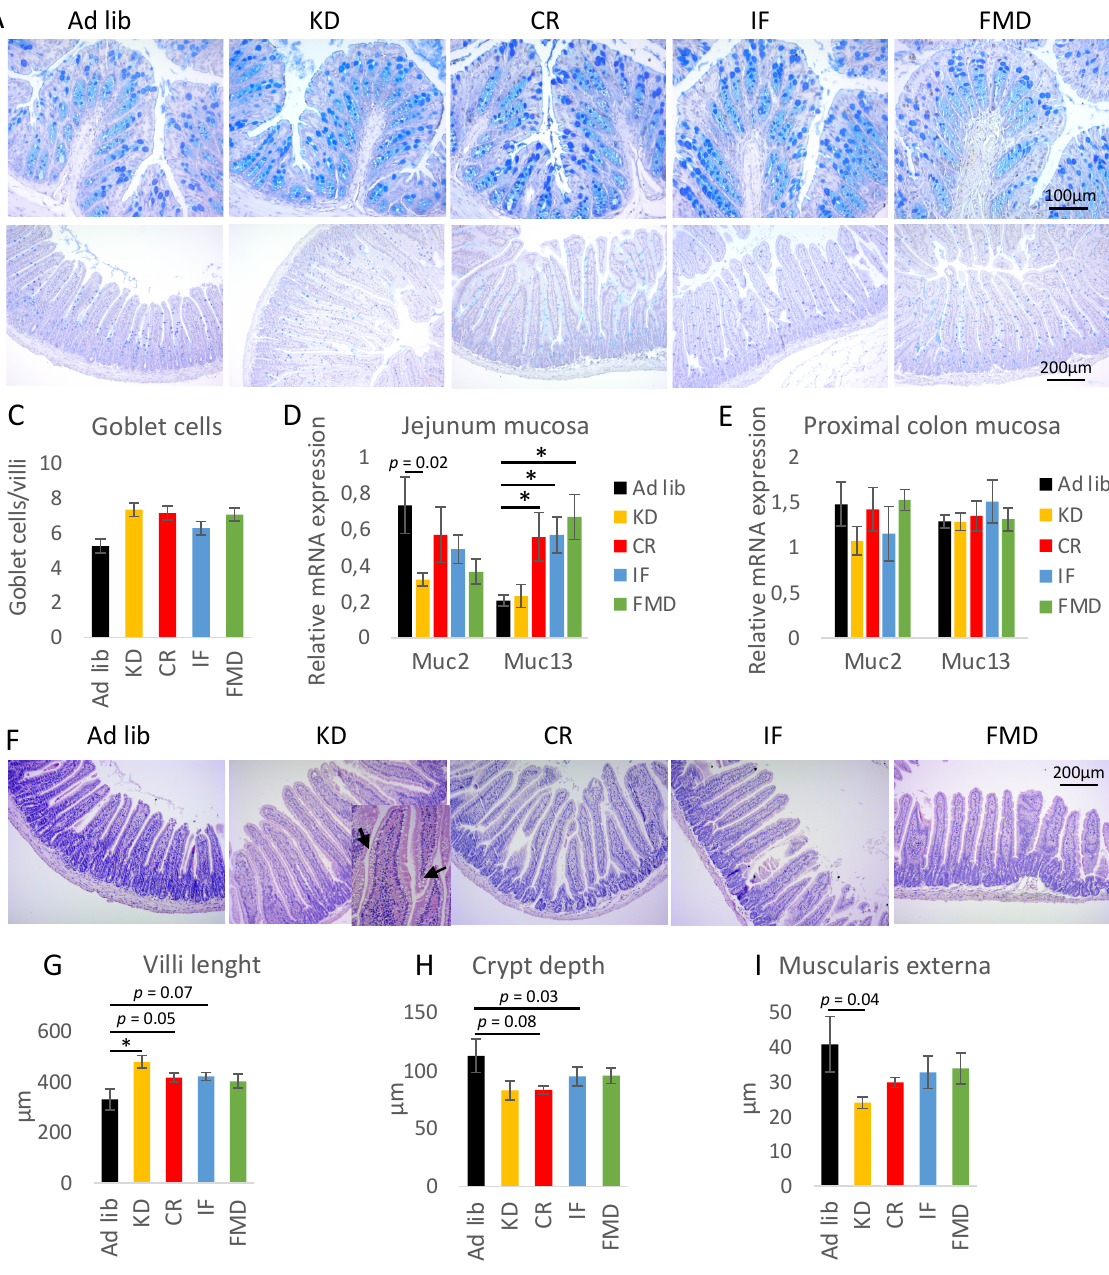
Figure 5. Restrictive diets have a small impact on goblet cells and mucus production in the GI tract, but affect intestine morphology. Histology sections of the colon ( A ) and jejunum ( B ) were stained with alcian blue periodic acid-Shiff (AB-PAS) to visualize goblet cells and mucus. The number of goblet cells per villi was counted in the jejunum sections ( C ). The mRNA expression of mucin (Muc2 and Muc13) genes was quantified in the mucosa of the jejunum ( D ) and proximal colon ( E ). Histological sections of jejunum were stained with hematoxylin-eosin ( F ), and the length of villi ( G ), depth of crypts ( H ), and thickness of muscularis externa ( I ) were quantified using ImageJ. Microscopy images were taken using Zeiss Axio Lab 5x HSF 22 microscope, Axiocam ERc 5s camera, and ZEN software (Zeiss efficient Navigation). The images were analyzed using ImageJ software. Statistical significance between experimental groups was evaluated using ANOVA and Tukey’s post hoc test. * p < 0.01; n = 6–8. Data are presented as the mean ± SEM. The scale bar in the last picture of A, B, and F is applied to all